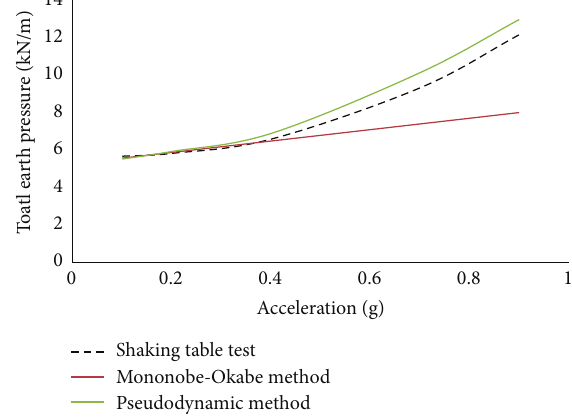
Figure 16: Comparison of measured total earth pressures and theoretical results by pseudostatic method and pseudodynamic method for rock foundation.